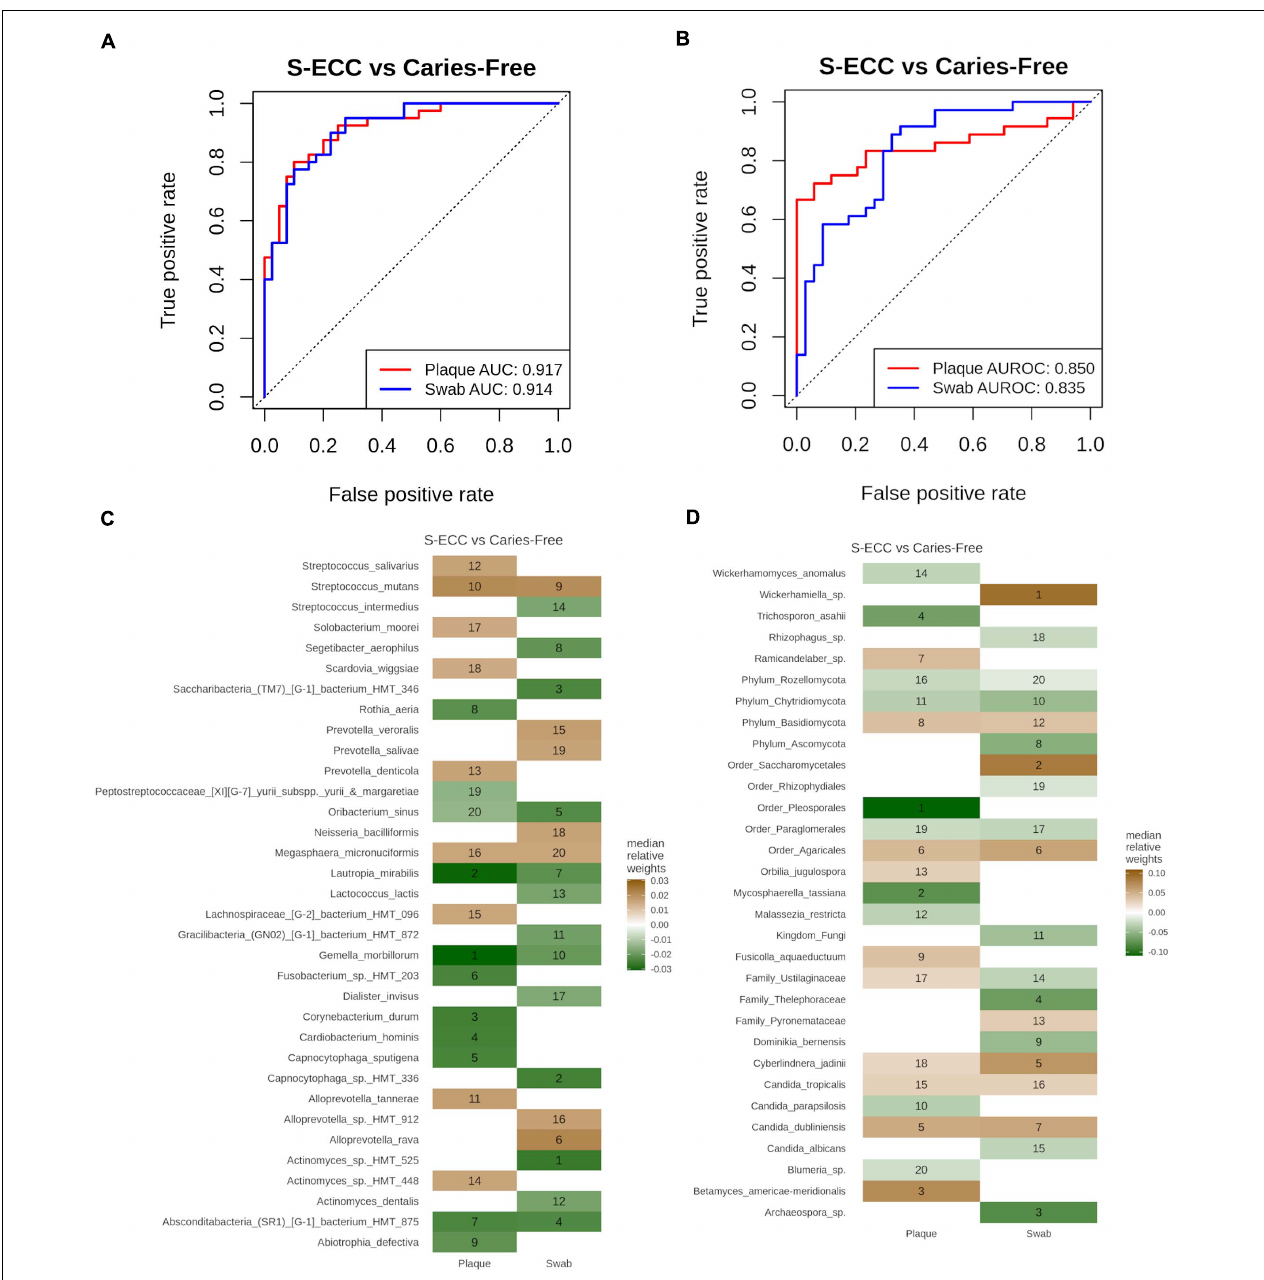
FIGURE 5 | Classification of S-ECC vs. caries-free. (A,B) Receiver operating characteristic (ROC) curve representing the cross-validation performance as for the classification of S-ECC and carries-free in (A) bacteria and (B) fungi using “Ridge” model in Siamcat. The area under the receiver operating characteristic curve (AUROC) represents the sample taken from dental plaques and oral swabs, by red and blue colors, respectively. AUROC values are shown in the bottom-right of the plot. (C,D) The relative feature weights used to predict the corresponding model. A maximum of 20 weights in each category were selected to plot on the heatmap and are marked with the ranking of the weights in the heatmap for bacterial (C) bacterial and (D) fungal taxa. The green color represents the features important in caries-free and brown is for